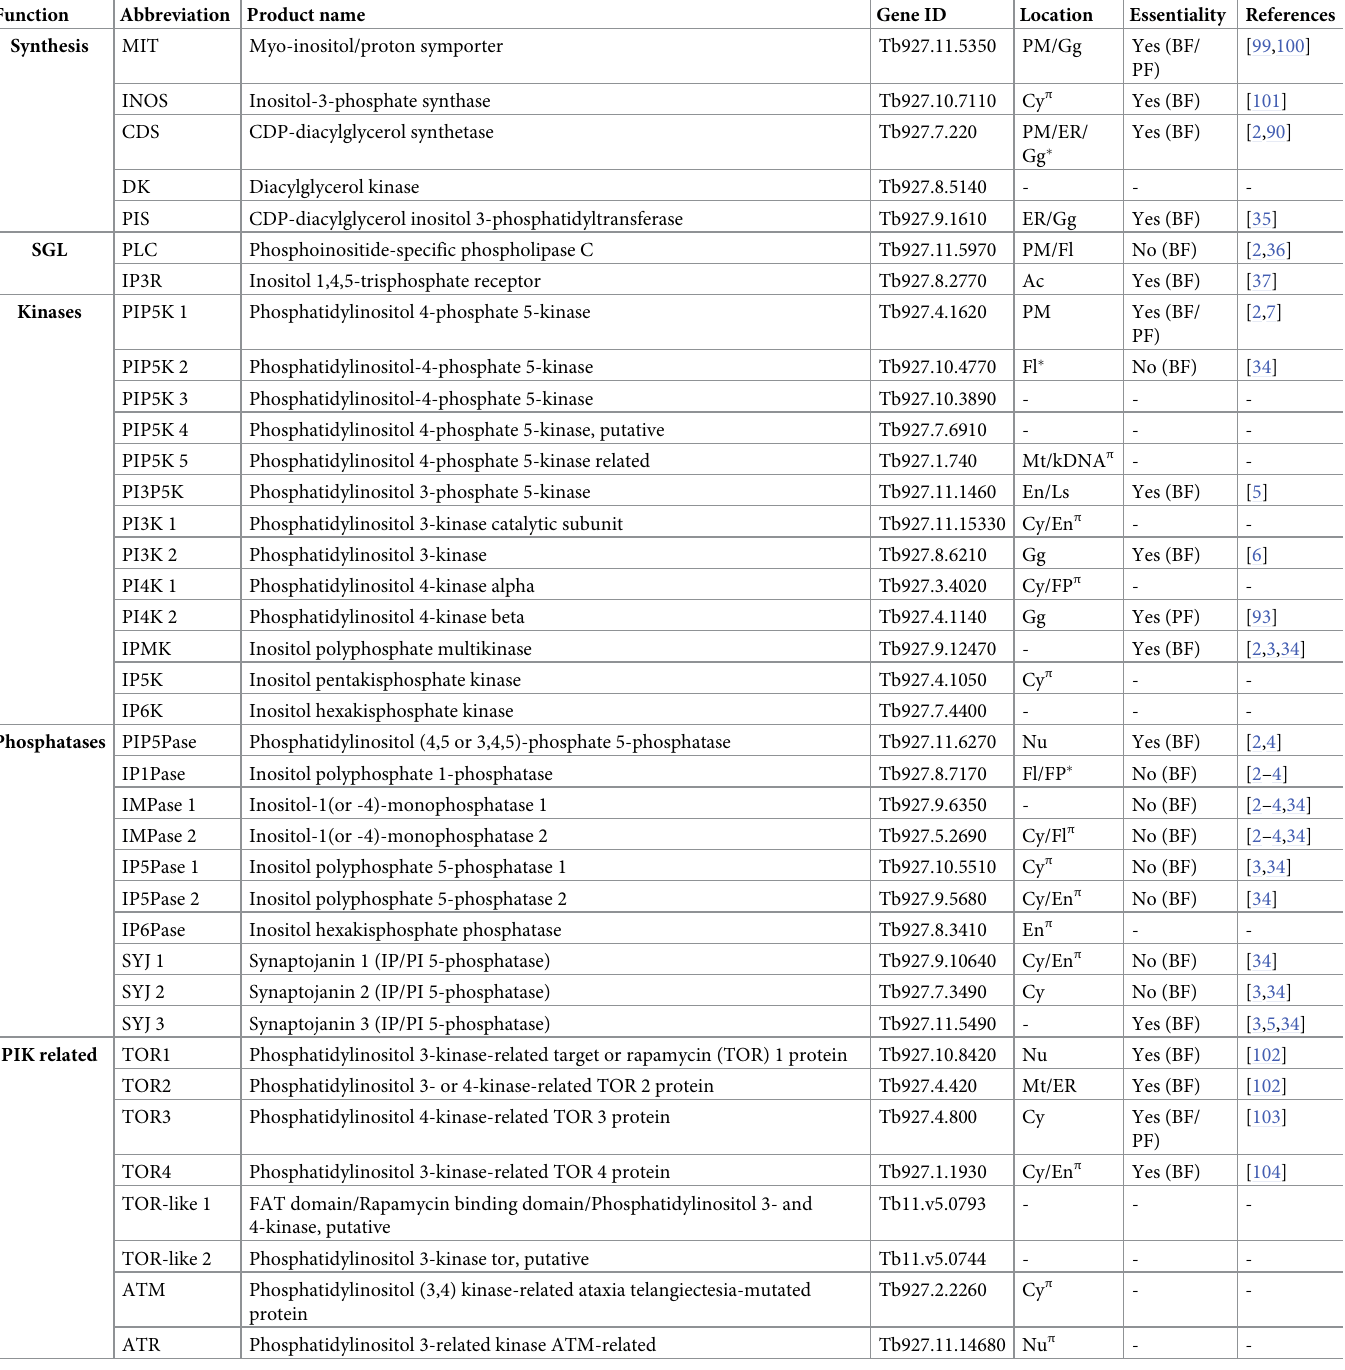
Table 1. PI system genes of T . brucei